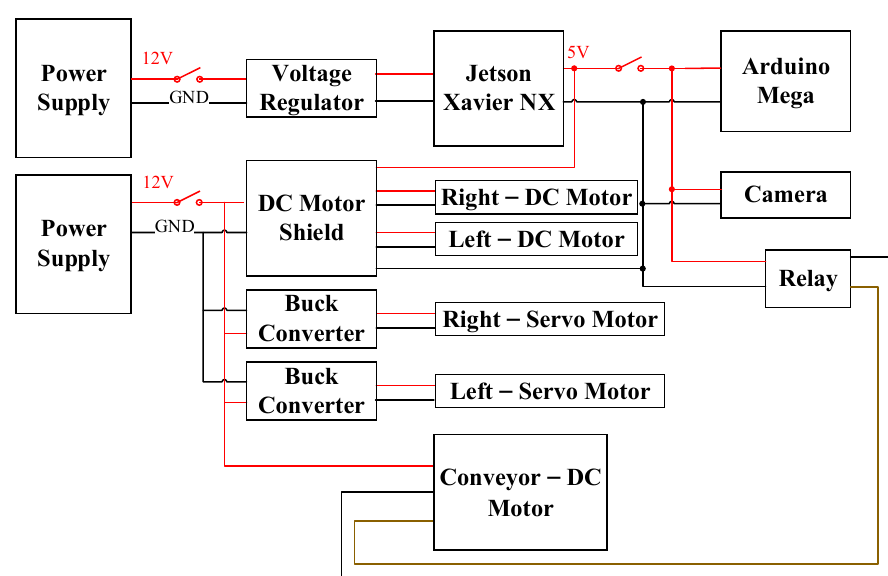
Figure 5. Hardware architecture of the designed system.